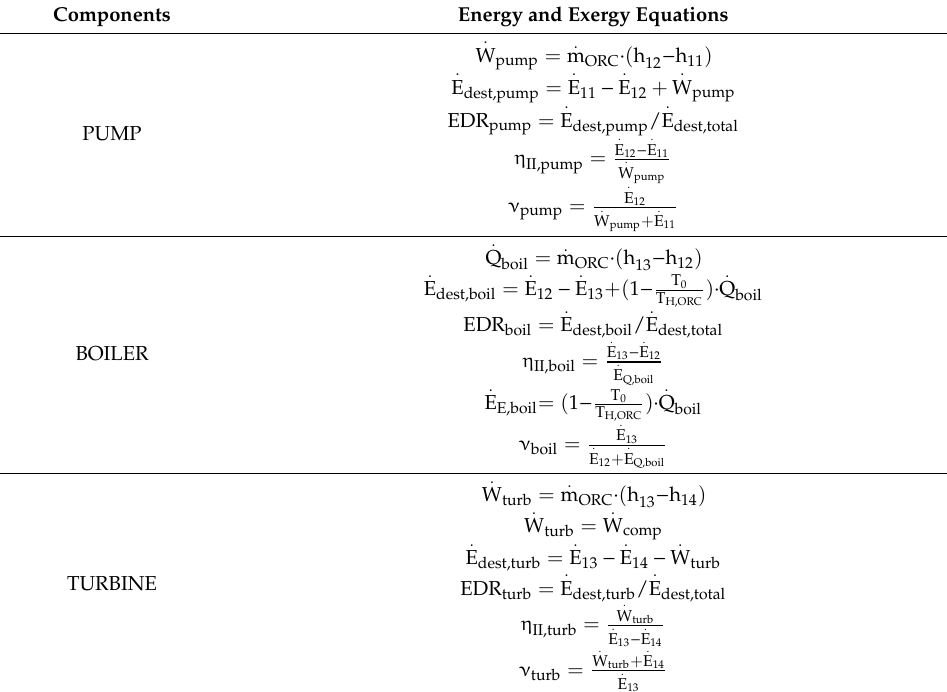
Table 7. Equations for ORC cycle components in combined ORC-dual evaporator VCR